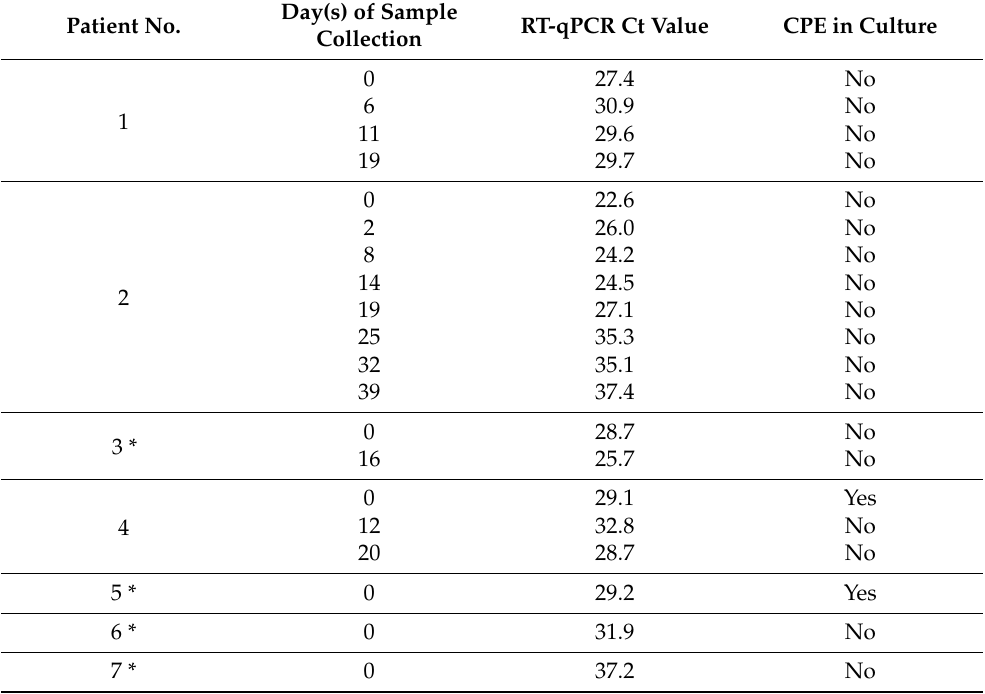
Table 1. Cell culture test results in children with SARS-CoV-2 RNA positive stool samples. All patients displayed here were diagnosed with COVID-19. A selection of SARS-CoV-2 positive stool samples ( n = 20) were tested in cell culture. CPE—cytopathic effect. * Hospitalized at the time of